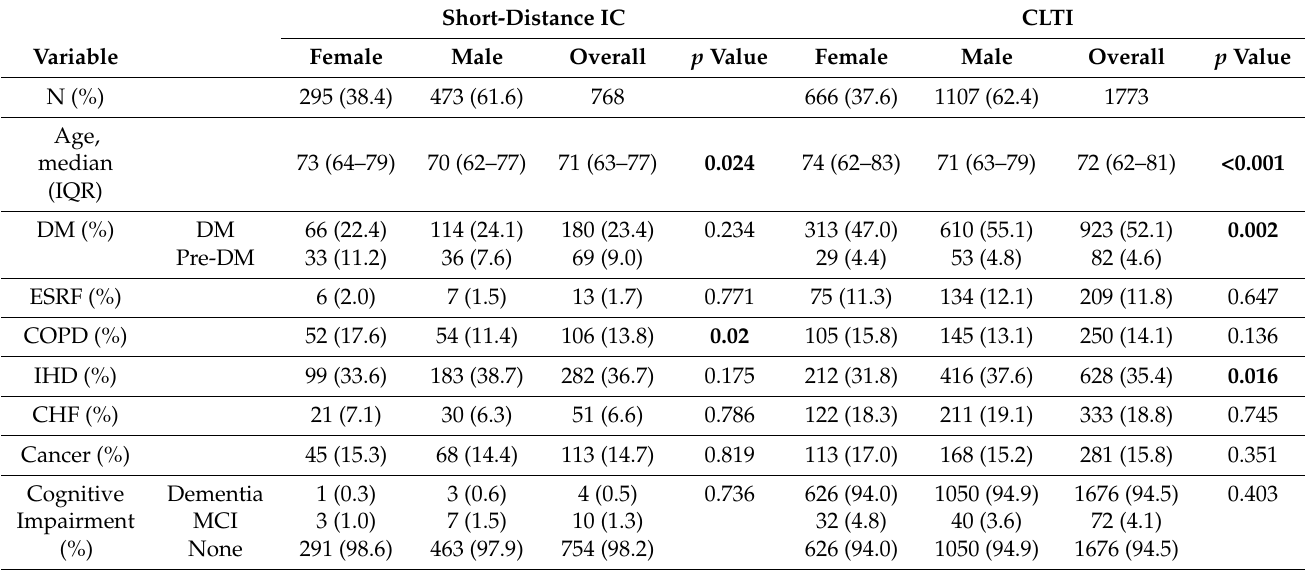
Table 1. Demographics of all patients at the time of first presentation with short-distance IC and